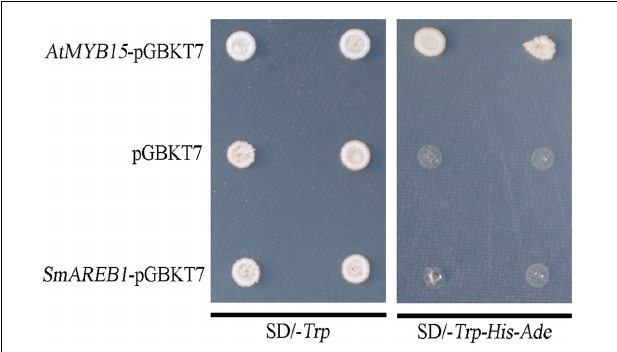
FIGURE 5 | Transactivation activity of SmAREB1 in yeast. Yeast cells carrying AtMYB15 -pGBKT7 (positive control), SmAREB1- pGBKT7, or pGBKT7 (negative control) were spotted onto SD/- Trp and SD/ -Trp-His-Ade plates, cultured at 30 ◦ C for 3 days,